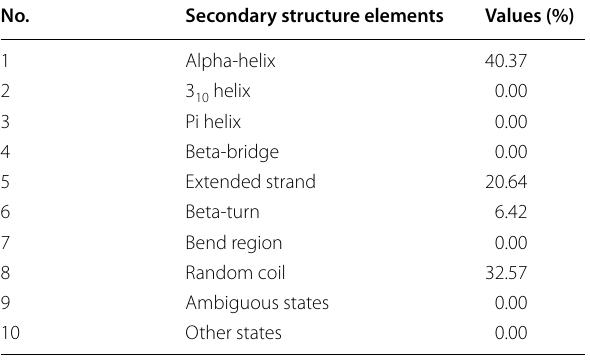
Table 3 Secondary structure elements prediction by SOPMA